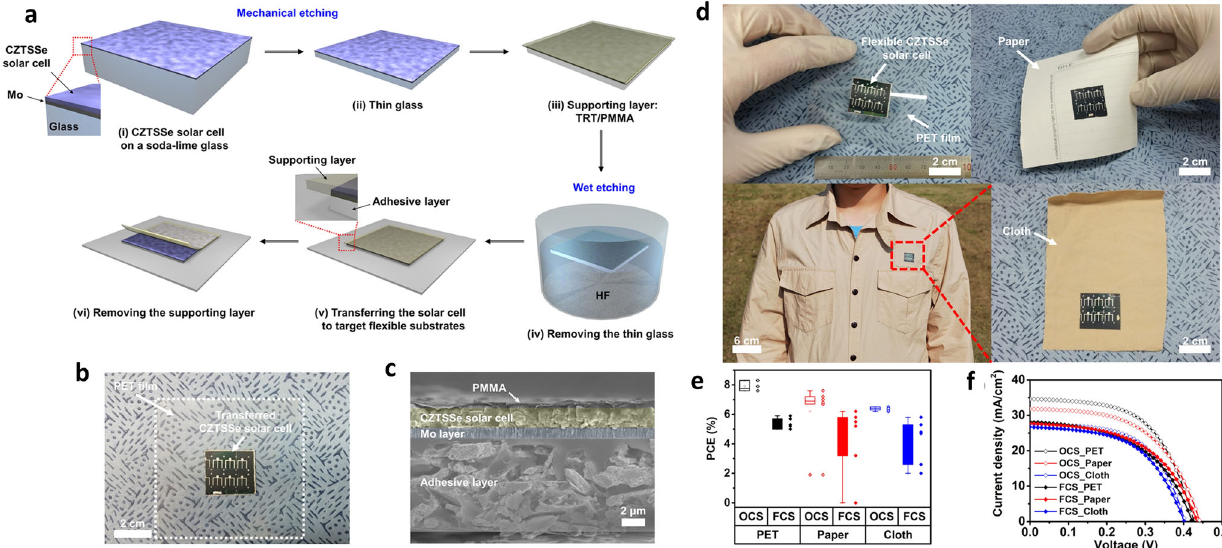
Fig. 3 Flexible CZTSSe thin- fi lm solar cells based on substrate-transfer method. a The process fl ow of the substrate transfer method. b Photo of a CZTSSe thin- fi lm sample transferred on to a PET substrate. c Cross-section SEM image of a transferred CZTSSe thin- fi lm solar cell. d Photo demonstration of fl exible CZTSSe thin- fi lm solar cells transferred on PET, paper, and cloth substrates. e , f Ef fi ciency and current density – voltage curves of the fl exible CZTSSe thin- fi lm solar cells transferred on different substrates respectively. Reproduced with permission 74 . Copyright 2020, American Chemical